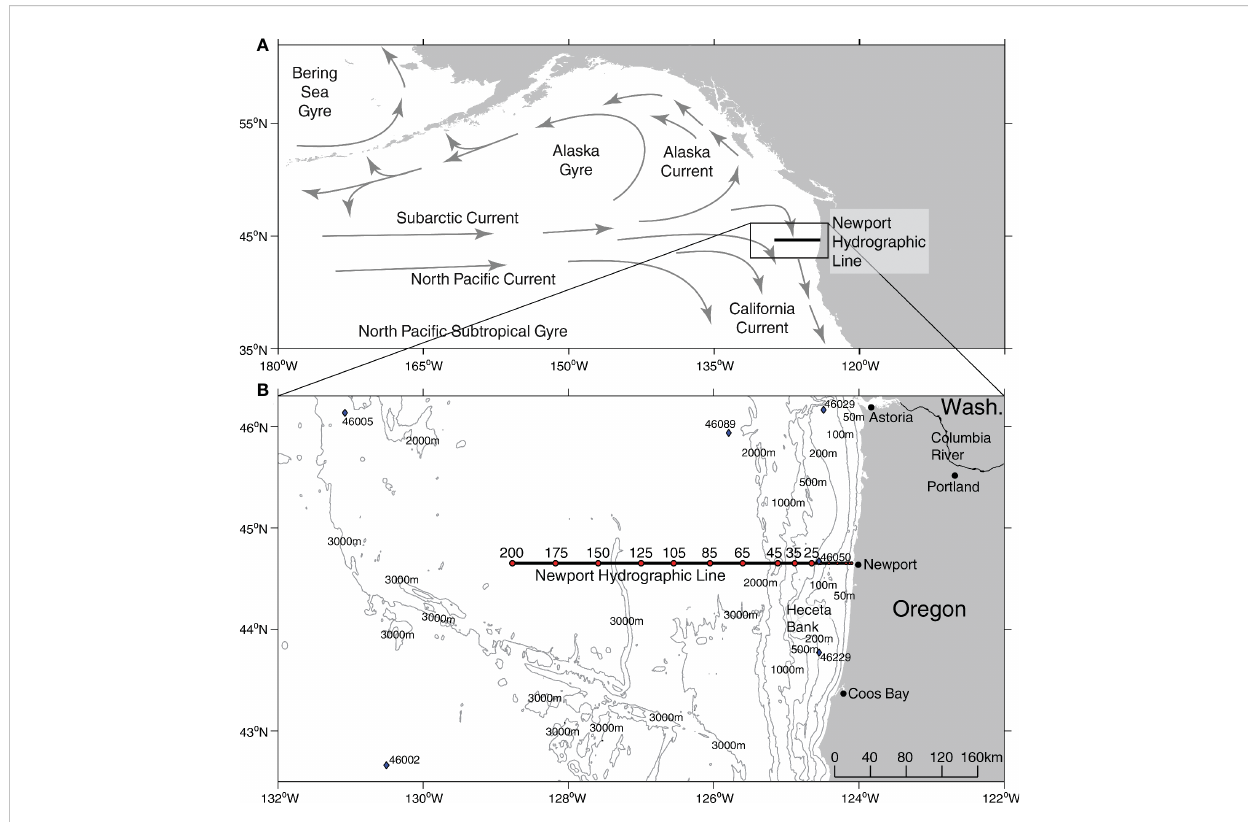
FIGURE 1 Study region. (A) Schematic map of Northeast Paci fi c oceanography. (B) Bathymetry along the Newport Hydrographic Line (black line) with individual sampling stations (red dots), and National Buoy Data Center buoys (blue diamonds). Bathymetry data from GEBCO Bathymetric Compilation Group